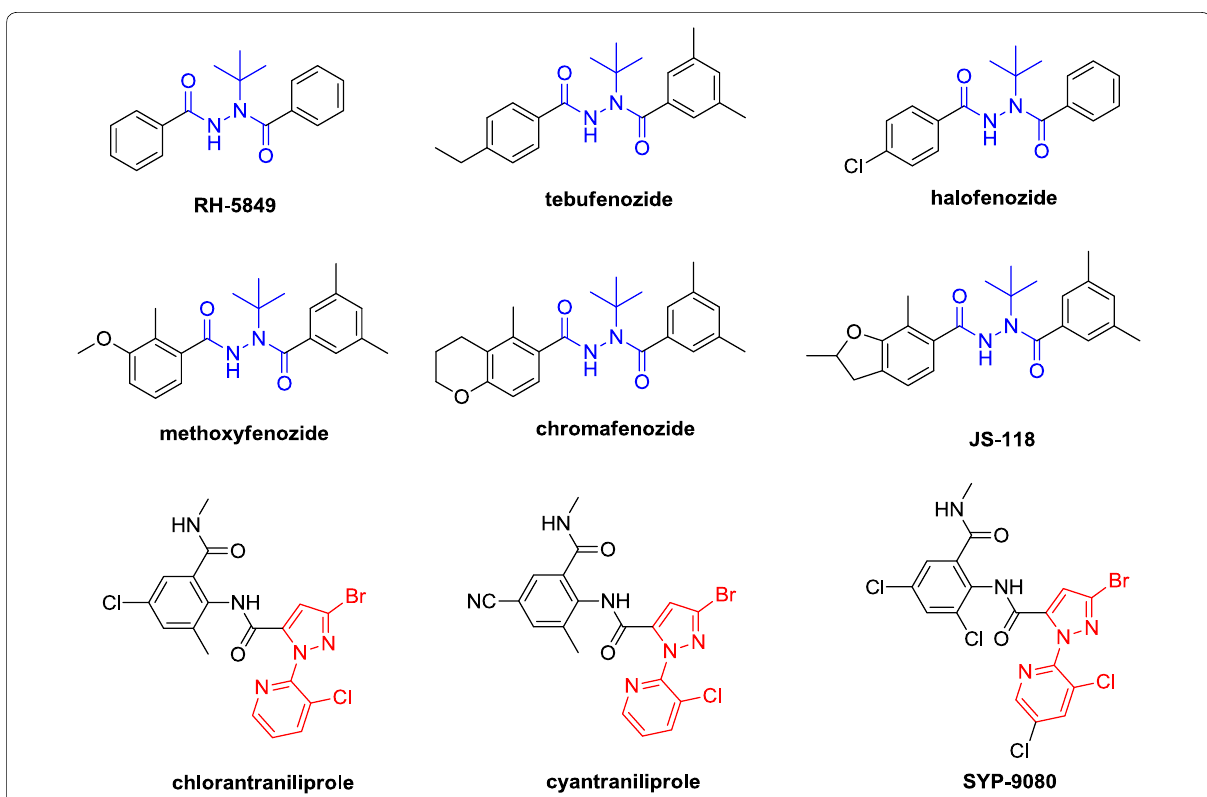
Fig. 1 The structures of commercial insecticides containing the substructures of diacylhydrazine and 3-bromo-1-(3-chloropyridin-2-yl)-1 H